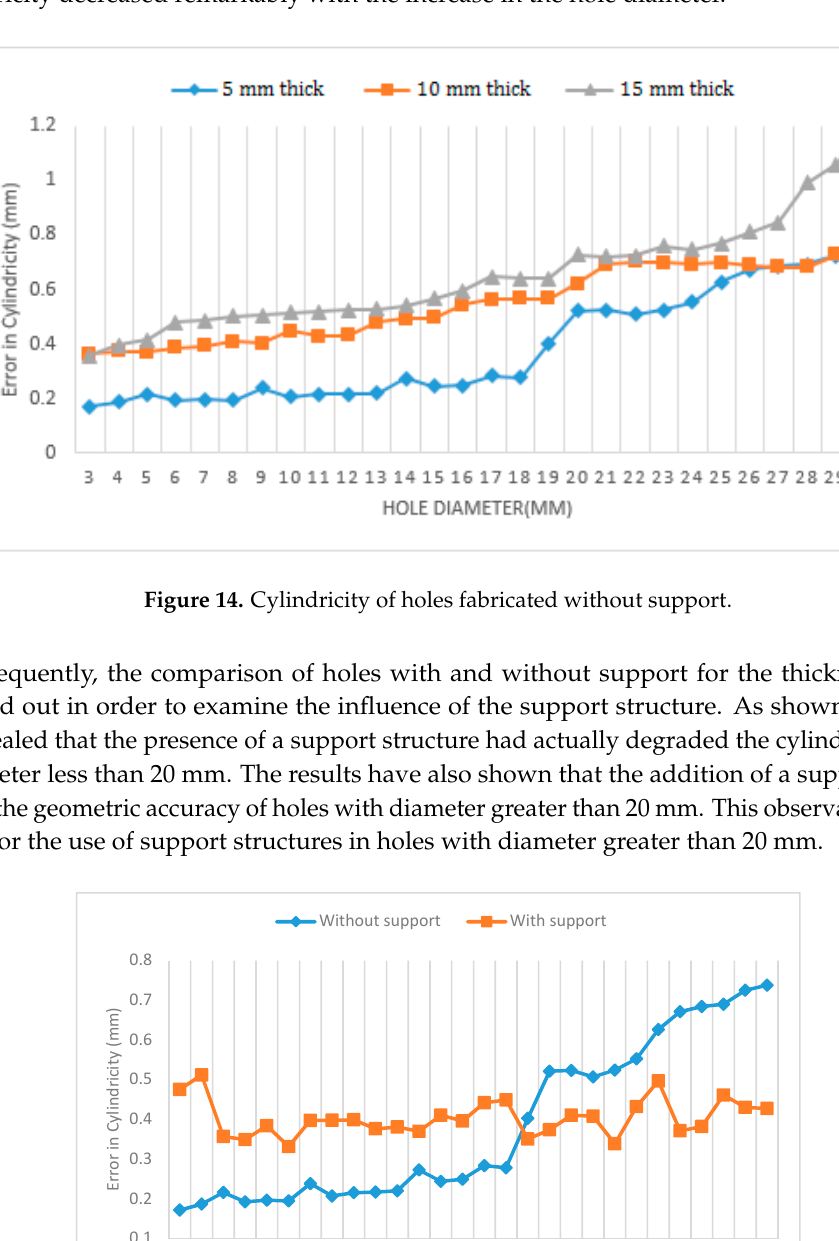
Figure 13. Hole without and with support structure.